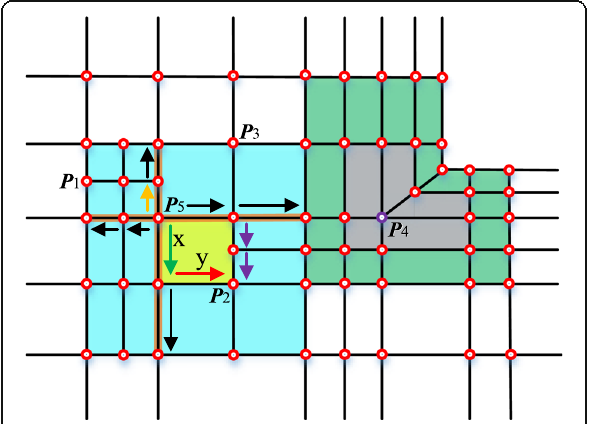
Fig. 8 Schematic of the local parametric algorithm